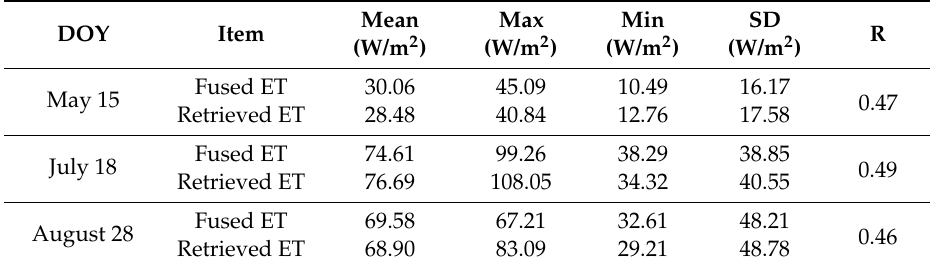
( c ) Figure 4. Histogram (top panel) of the difference between fine-resolution LE data fused by the SADFAET (right panel) and the estimates directly retrieved by the ESVEP model using Landsat 8 data (left panel) on ( a ) May 15, ( b ) July 18 and ( c ) August 28. Table 6. Comparison between instantaneous ET fused by the SADFAET and that directly retrieved by the ESVEP model from Landsat 8 data on typical days (in spring, summer and autumn) over the study area. Max: maximum ET; Min: minimum ET; SD: standard deviation; R: correlation coefficient.